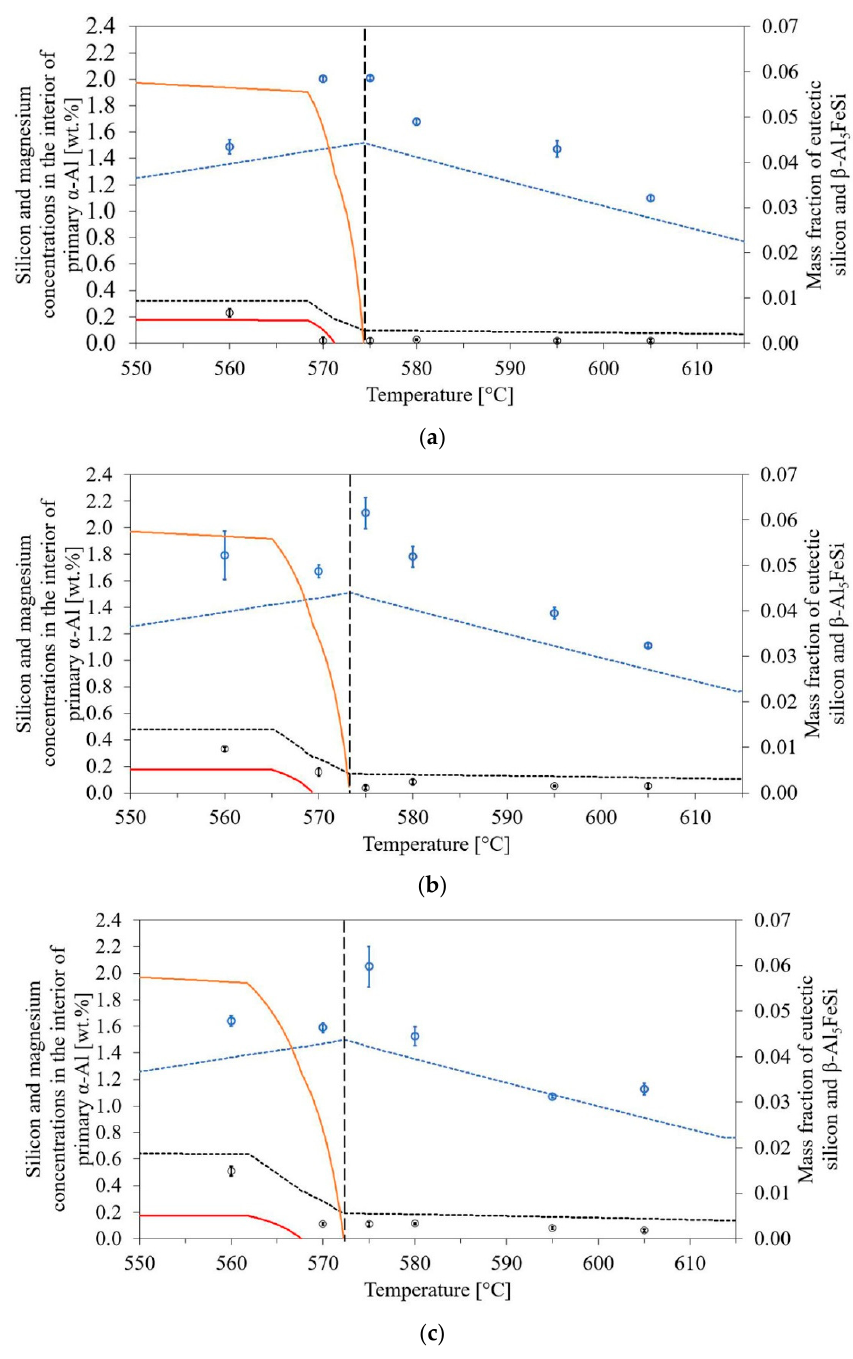
Figure 6. Concentrations of magnesium and silicon measured in the interior of primary α -Al after isothermal holding treatments, and predicted by Thermocalc ™ as a function of temperature for the alloys: ( a ) Al-7Si-0.3Mg, ( b ) Al-7Si-0.45Mg and ( c ) Al-7Si.0.6Mg. The vertical dashed lines denote the equilibrium start temperature of the Al-Si eutectic reaction. Error bars show the standard deviation of the